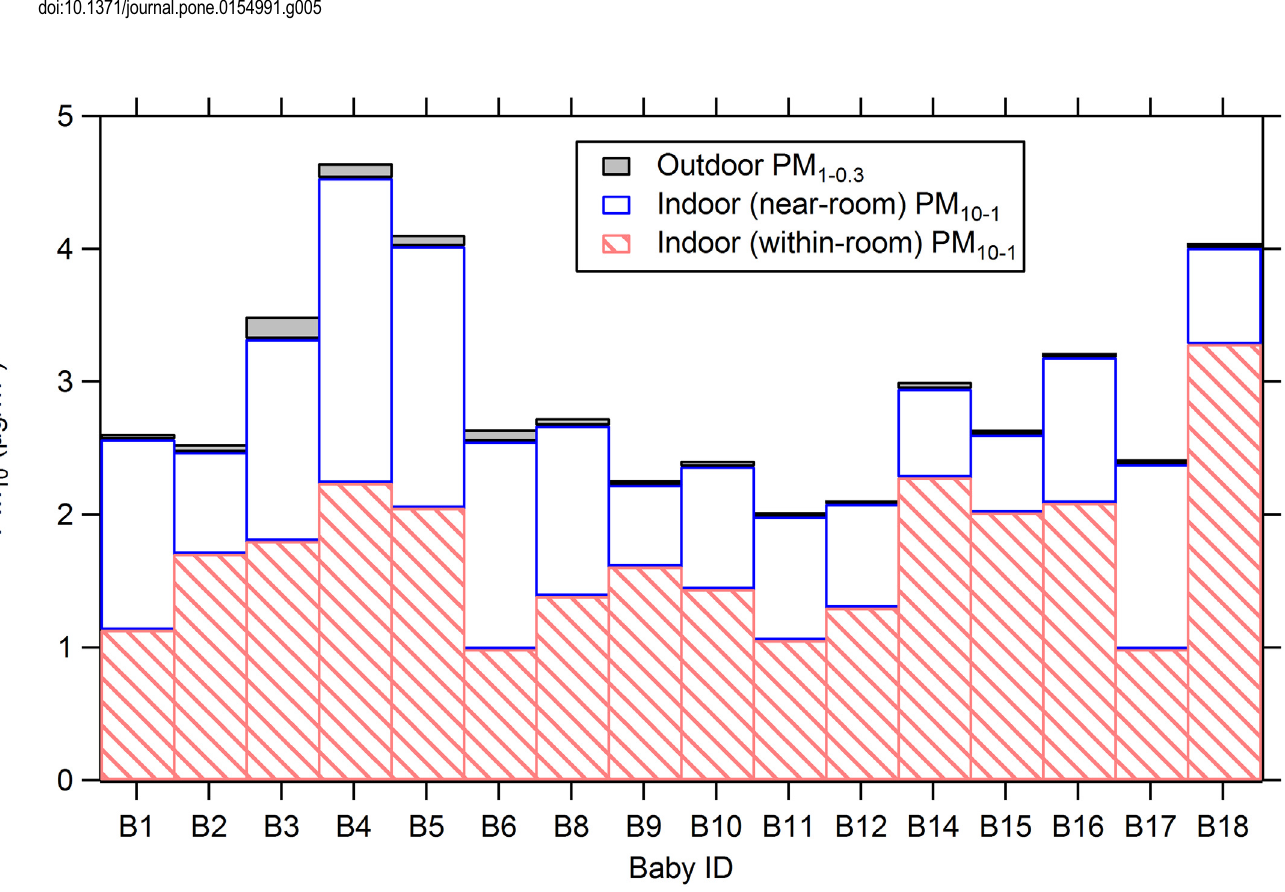
Fig 6. Comparison of individual contributions to PM 10 mass in the baby rooms from three sources: Indoor (within room) emissions, indoor (near room) emissions, and outdoors.